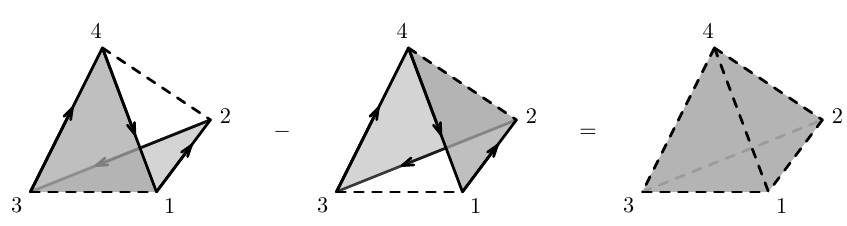
Figure 4 . Square move: the simplest example of a sphere